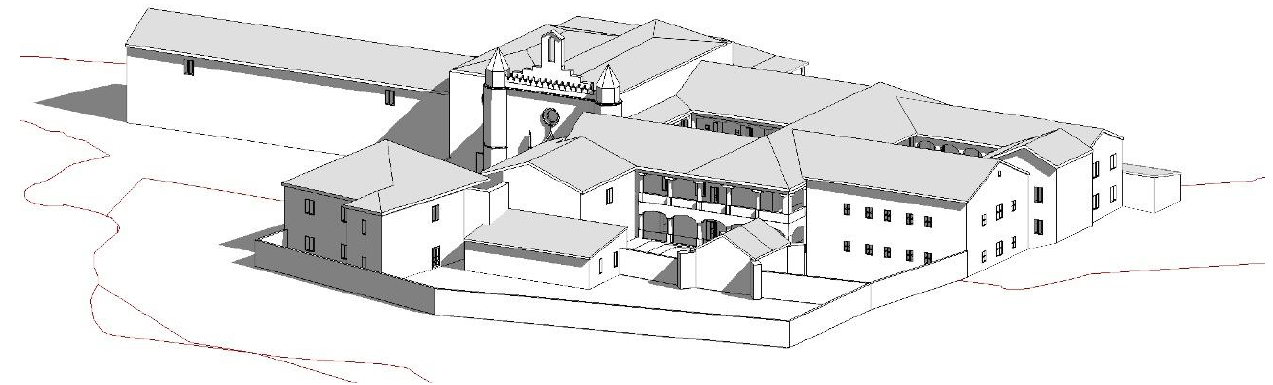
Figure 7. Perspective sketch of the current state of the monastery,